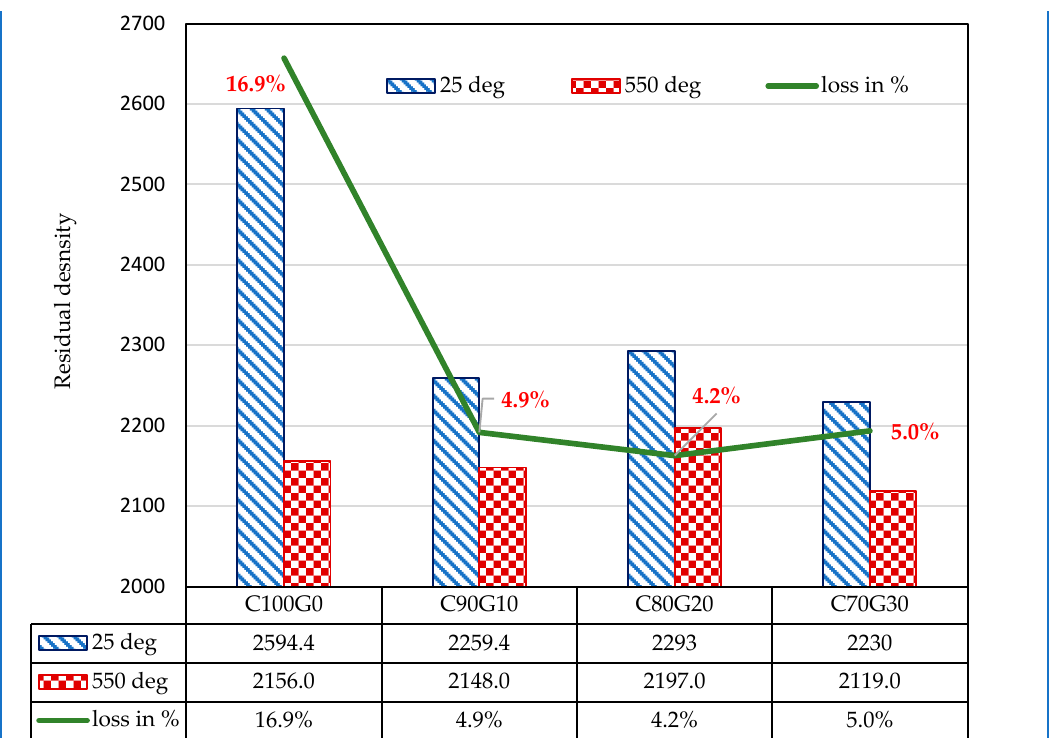
Figure 17. Residual density of glass blended concrete exposed to elevated temperature.